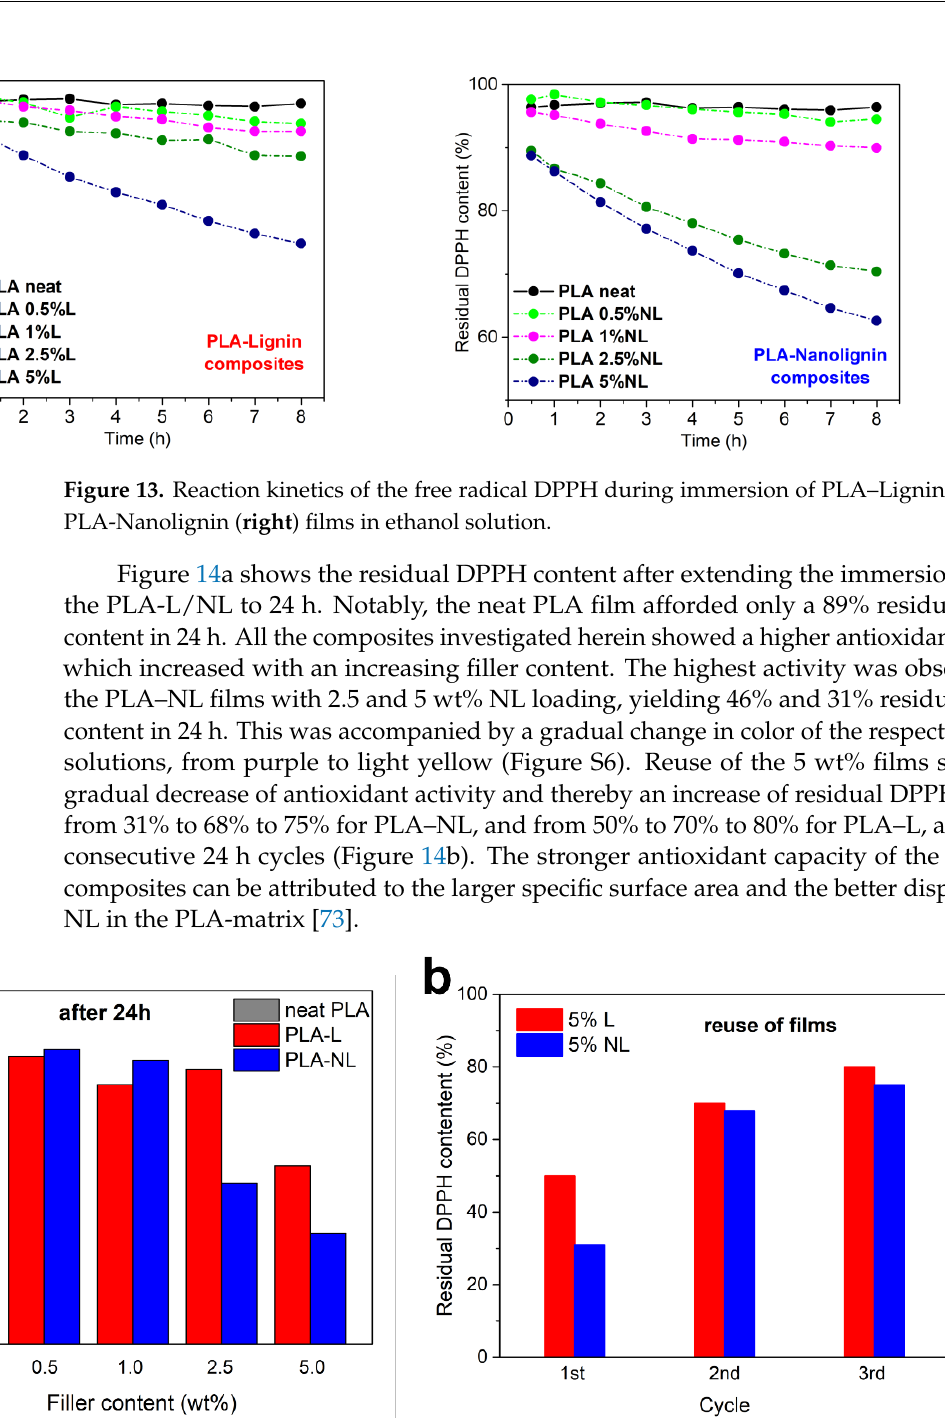
Figure 14. Residual DPPH content of composites after 24 h incubation ( a ). Reuse of the PLA–L/NL films with 5 wt% filler content ( b ).